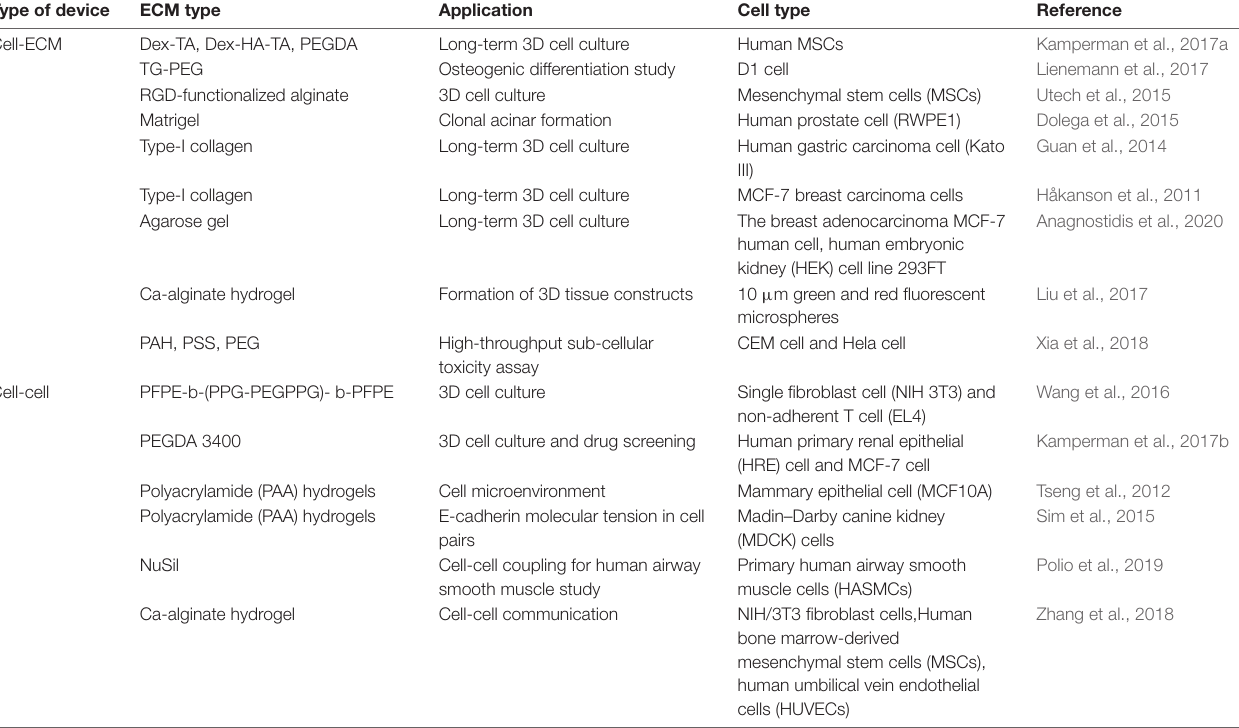
TABLE 2 | Types of microfluidic devices and their applications in 3D intercellular